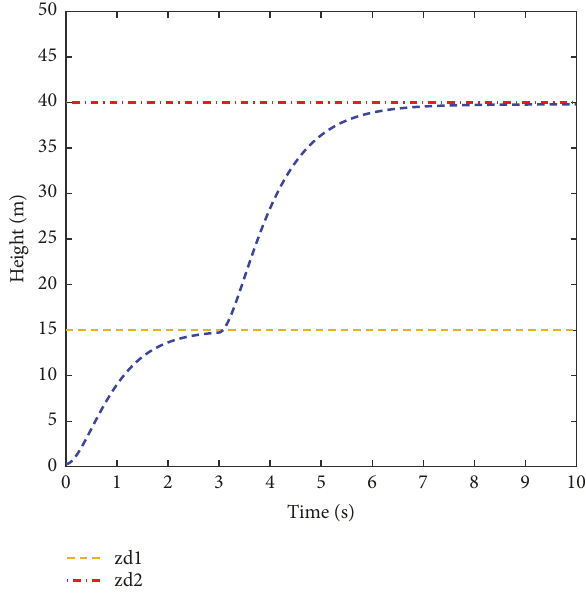
Figure 10: Altitude control during transition mode.